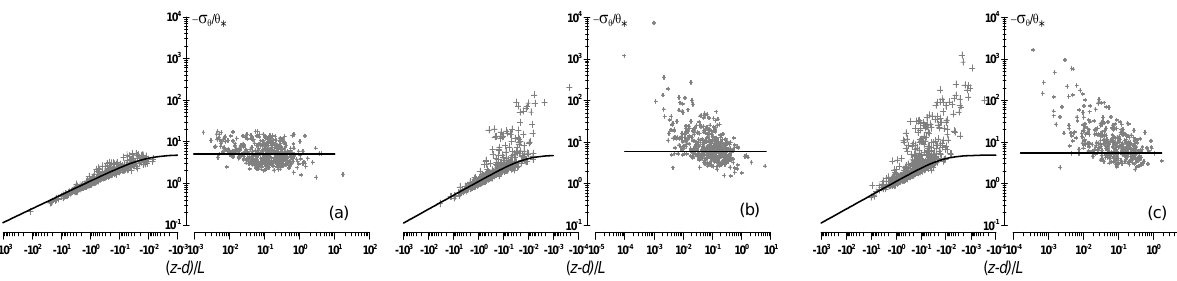
Figure 9. MOS relations of temperature variance of in different scale eddies of NSPCE; (a) , (b) and (c) , respectively, represent the similarity of the eddies of 10, 30 and 60min at the temporal